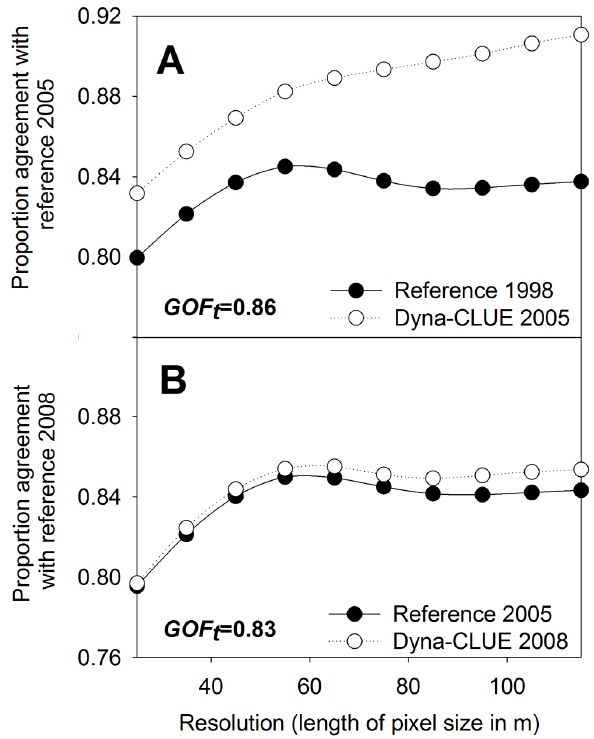
Figure 5. Goodness-of-fit ( GOFt ) of TREND scenario simulated for the period of 1998 to 2008, with ( A ) computations for the period of 1998–2005 and ( B ) for 2006–2008, with GOFt = 1 referring to a perfect model fit.